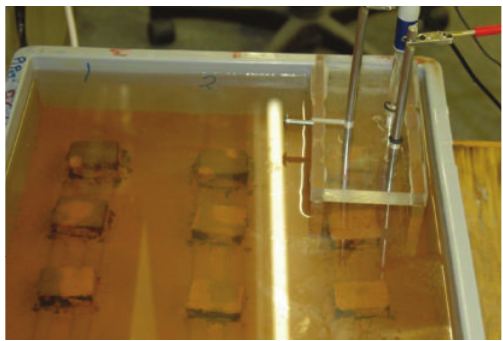
Figure 3: Test setup for specimens in test